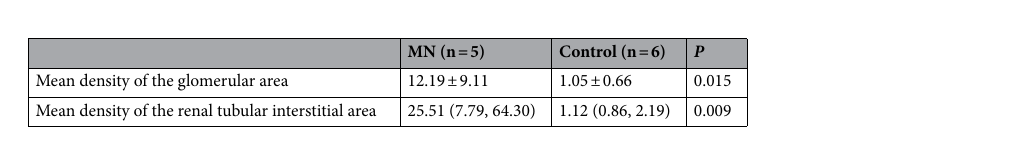
Table 4. Level of MIF expression in the renal